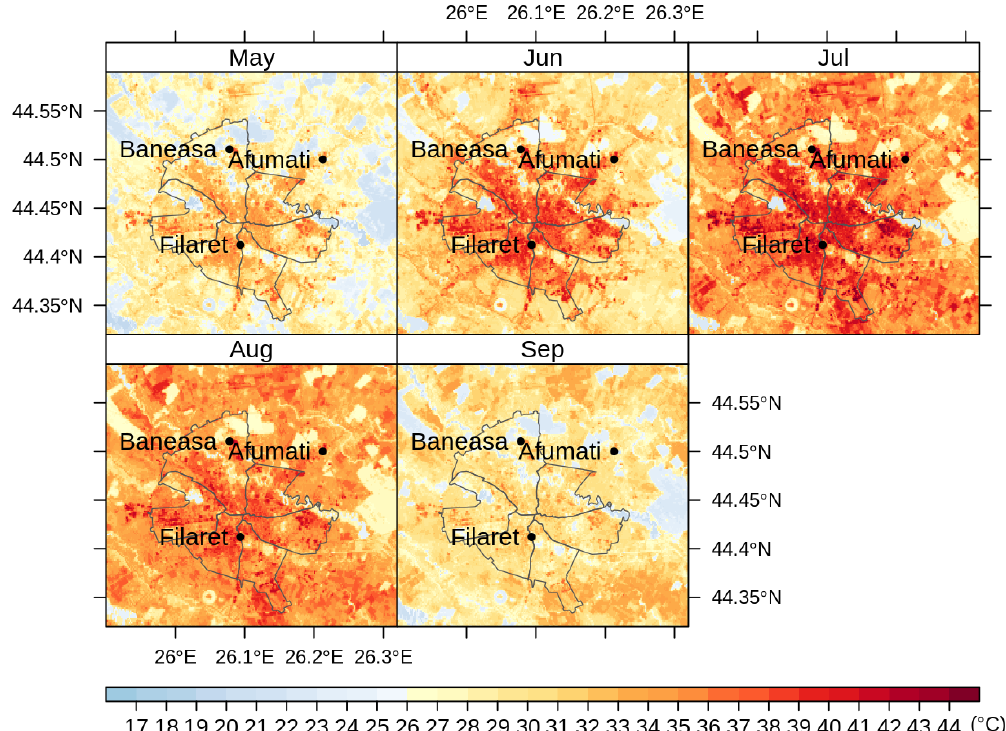
Figure 8. Average monthly LST values (°C) over Bucharest retrieved from Landsat 8 imagery (2013–2018). Figure8. Average monthly LST values ( ◦ C) over Bucharest retrieved from Landsat 8 imagery